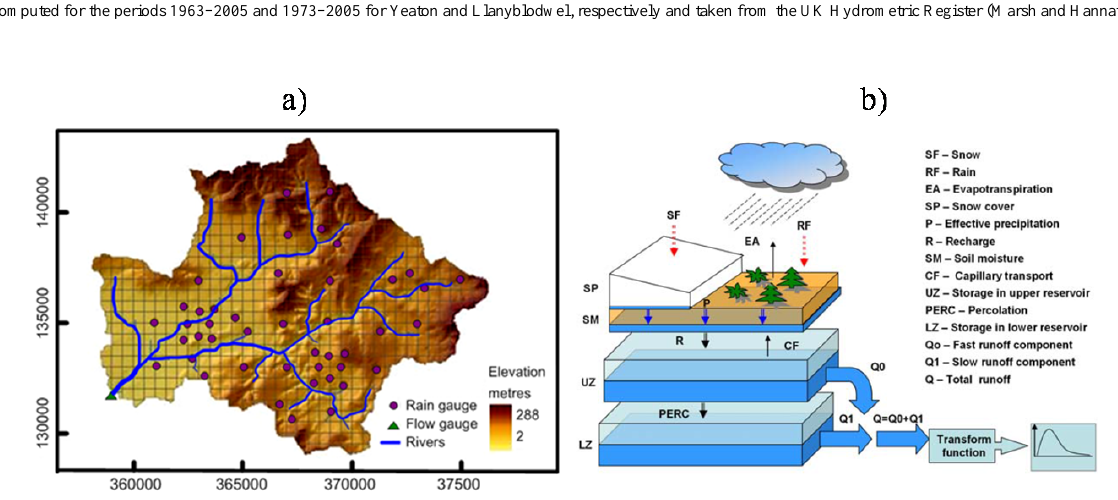
Figure 3. (a) The Brue catchment showing a dense rain-gauge network and its river-gauging station, Lovington, where the discharge is measured, and (b) schematic representation of the HBV-96 model (Lindström et al., 1997) with the routine for snow (upper), soil (middle), and response (bottom) (Shrestha and Solomatine,